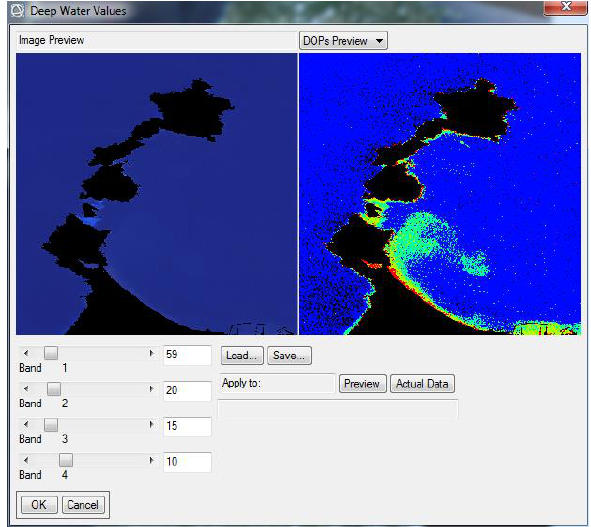
Figure 8. Depth images calculated on the scene acquired in 2014.